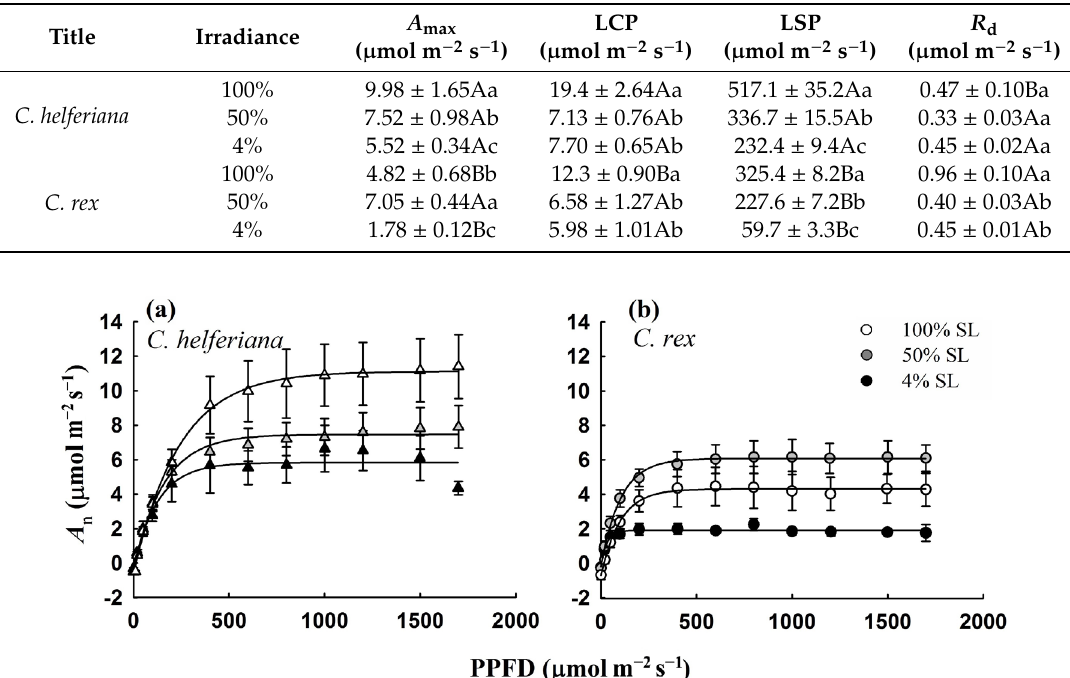
Figure 2. Photosynthetic response curves of ( a ) C. helferiana and ( b ) C. rex seedlings grown under three different light conditions, i.e., 100%, 50% and 4% sunlight (SL). Values are means ± 1SE ( n = 4).